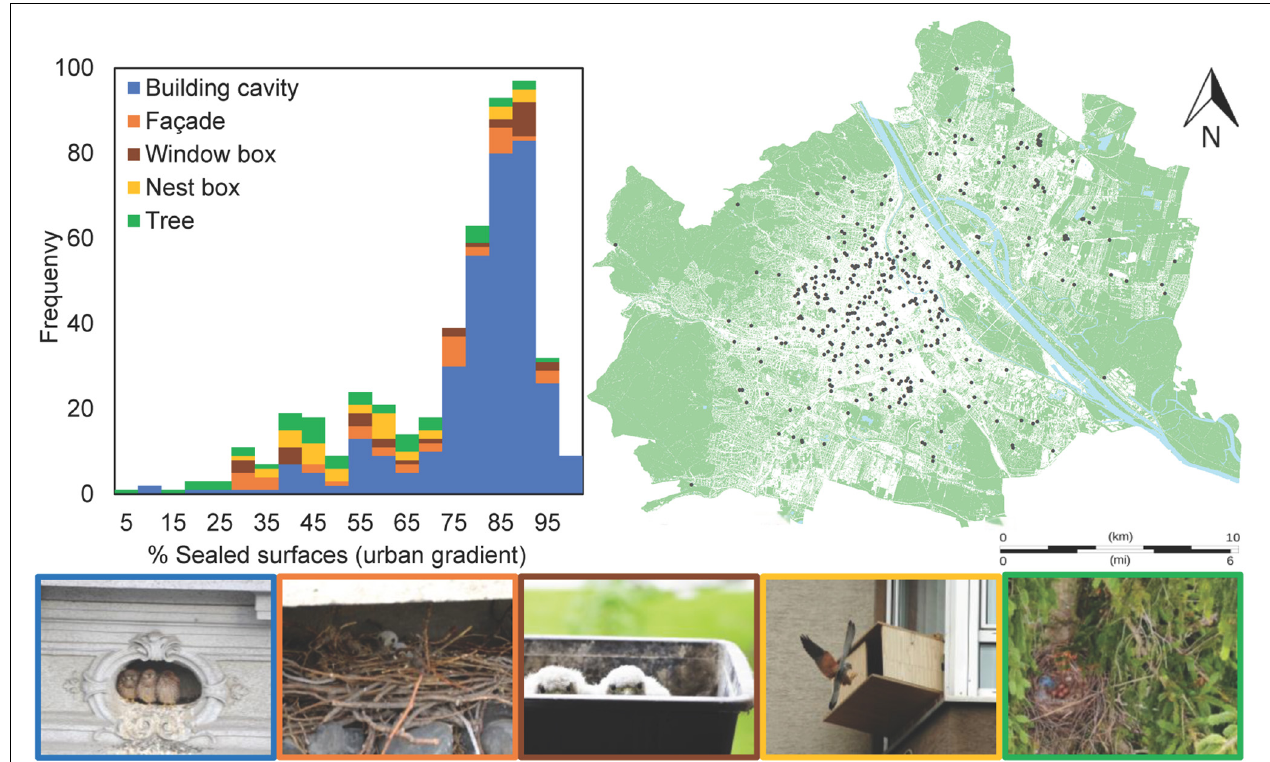
FIGURE 1 | (Left) Distribution of nest types along the urban gradient ( n = 484, 2010–2018): roof openings or other building cavities (66%), corvid nests on the façade (7%) or in trees (8%), window boxes (6%) and specifically provided nest boxes (6%). (Right) Location of nest sites monitored by citizen science community (occupied in at least 1 year; n = 366; gray points). Water bodies in blue, sealed surfaces in white and greenspace. (Below) Building cavity ©C Hofmann, corvid nest in façade ©M Graf, window box ©P Sumasgutner, nest box ©GF Witting and corvid nest in tree ©SC